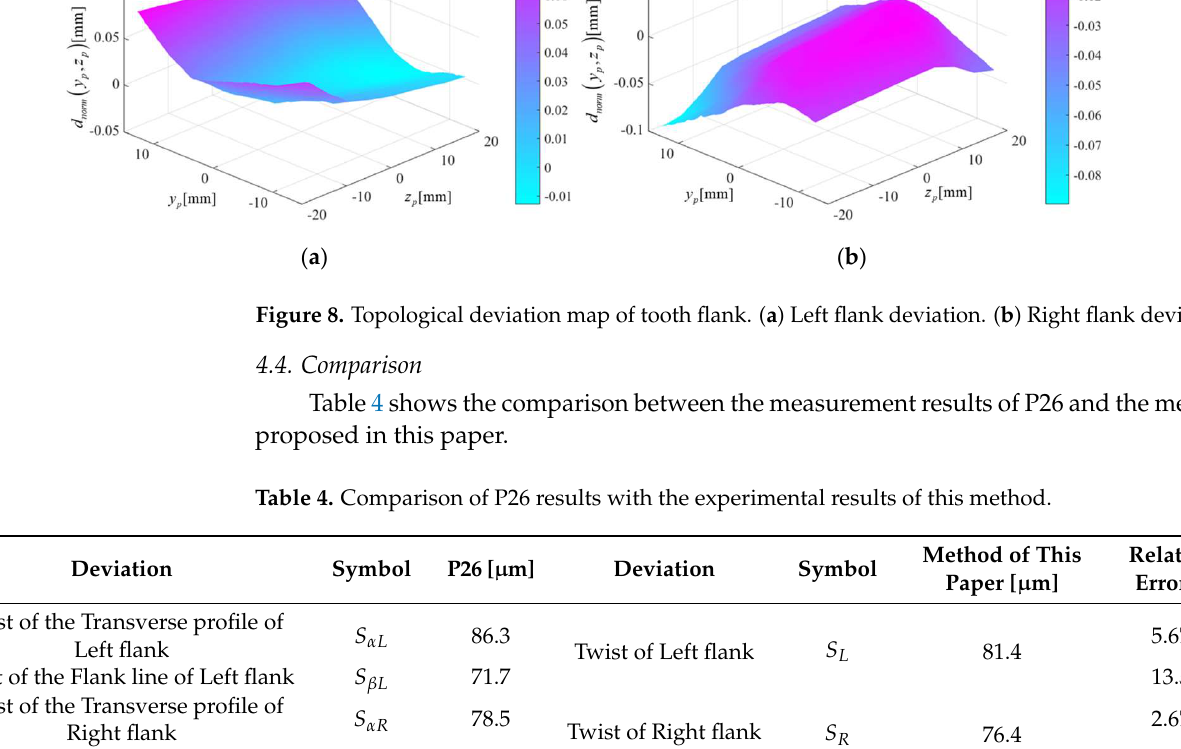
Figure 9. 2-D Legendre coefficients of the measurement. ( a ) 2-D Legendre coefficients of the left flank . ( b ) 2-D Legendre coefficients of the right flank .